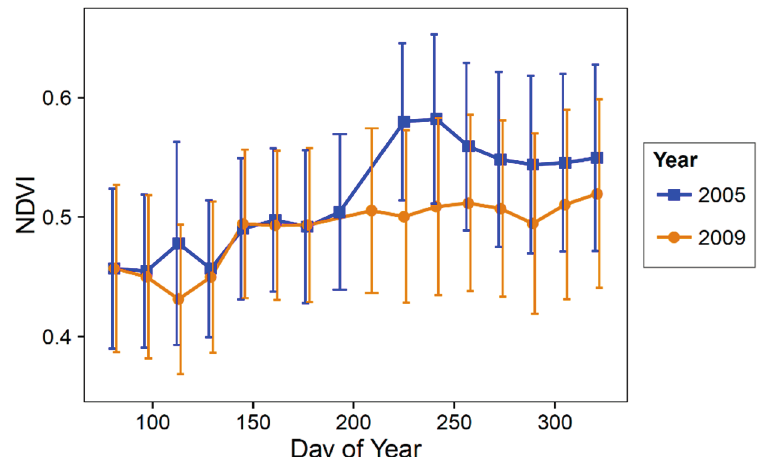
Figure 5. Mean NDVI values of all ponderosa pine STARFM pixels from the contrasting precipitation years of 2005 (wet) and 2009 (dry). Error bars represent ± 1 one standard deviation. The effect of the lack of monsoon activity is evident in the 2009 profile, which diverges markedly from the 2005 response. To highlight the different vegetation dynamics between the years, the y-axis range has been reduced to (0.35,